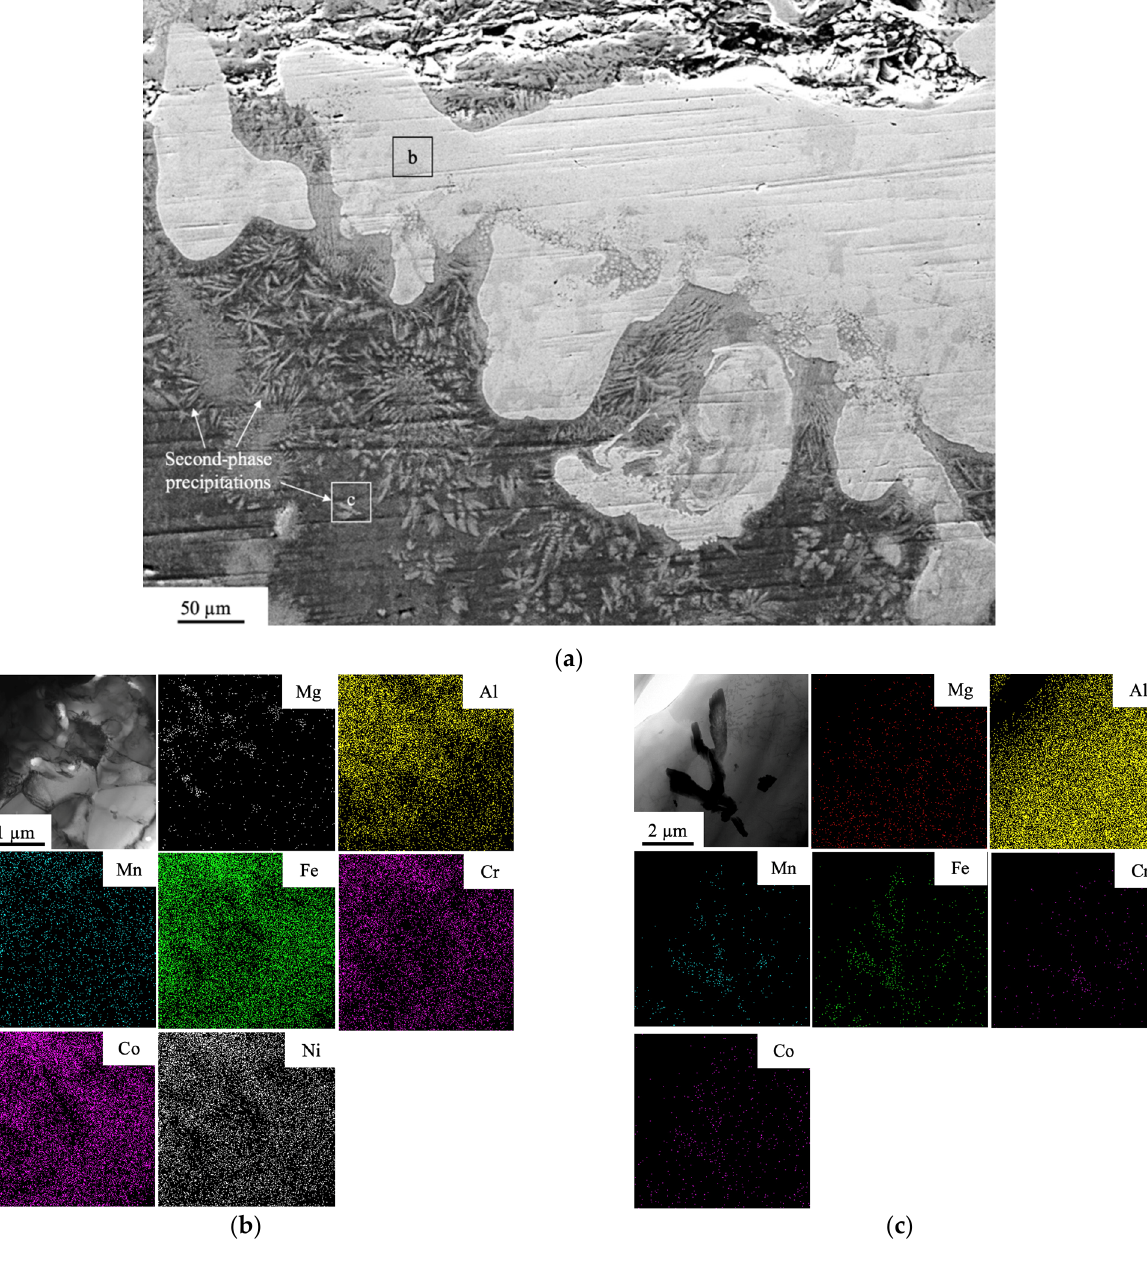
Figure 3. ( a ) SEM of the transition zone between the Al-Co-Cr-Fe-Mn-Ni coating and the AA5083 substrate, ( b ) TEM bright-field image and the elemental mapping of the area ( b ) indicated in ( a ), ( c ) TEM bright-field image and the elemental mapping of the area ( c ) indicated in ( a ). Table 1. Chemical composition of second-phase precipitations in the transition zone (at. precipitates. The second-phase precipitate has the crystal structure of Al 13 Fe 4 .